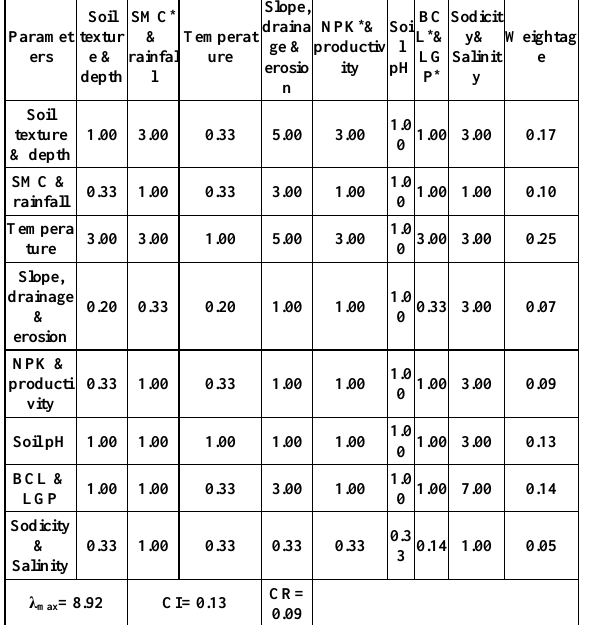
Table 7. Pairwise comparison matrix of selected criteria’s and their weights for Wheat